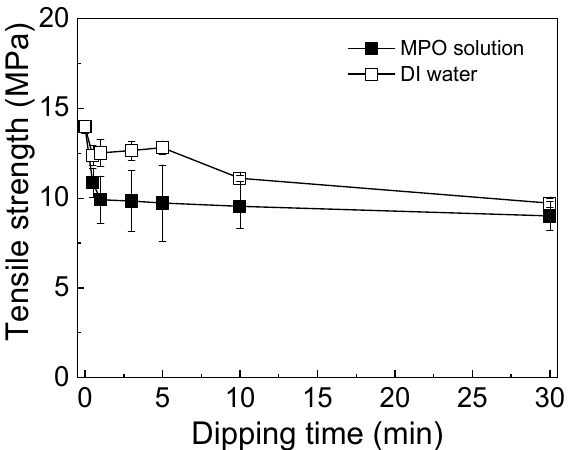
Figure 10. Tensile strengths of the UiO-66 / DSPD composite films as a function of dipping time. The composite film had the UiO-66 content of 15.3 wt.%, and tensile tests were performed 3 h after dipping.